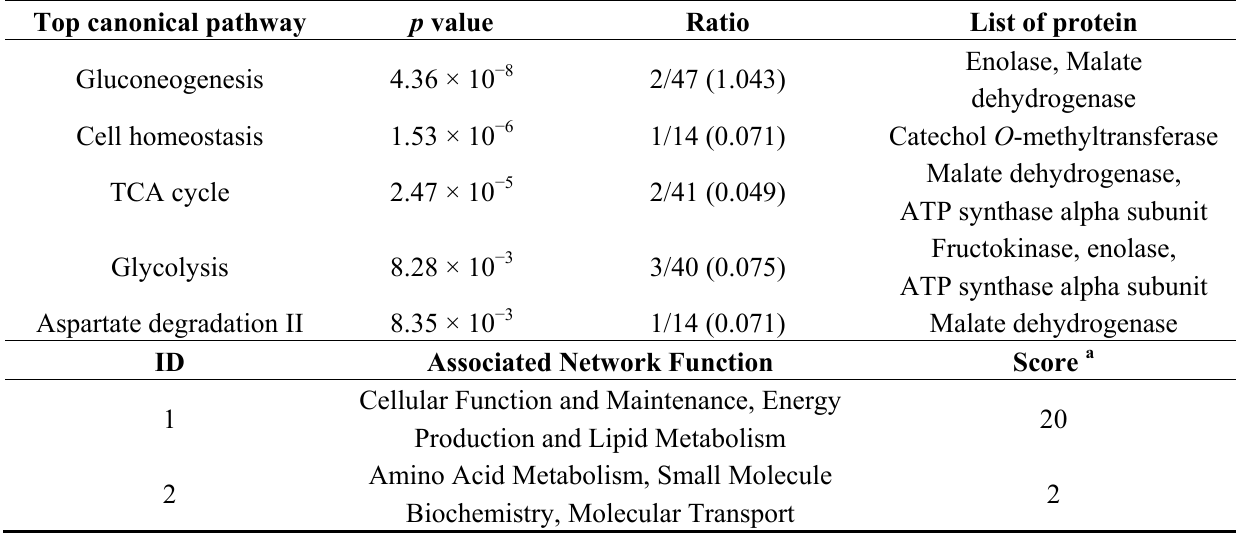
Table 2. Summary of ingenuity pathway analysis